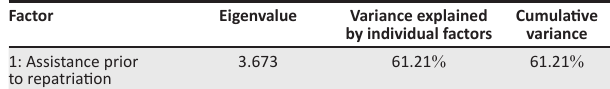
TABLE 5: Eigenvalue and variance explained.